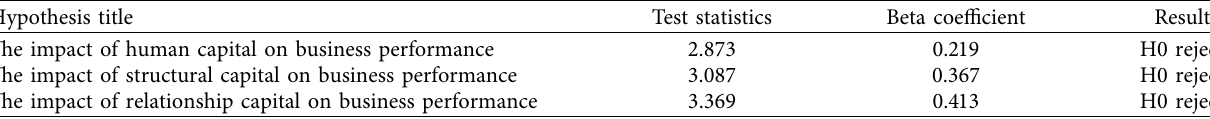
Table 3: Conclusion of research hypotheses.